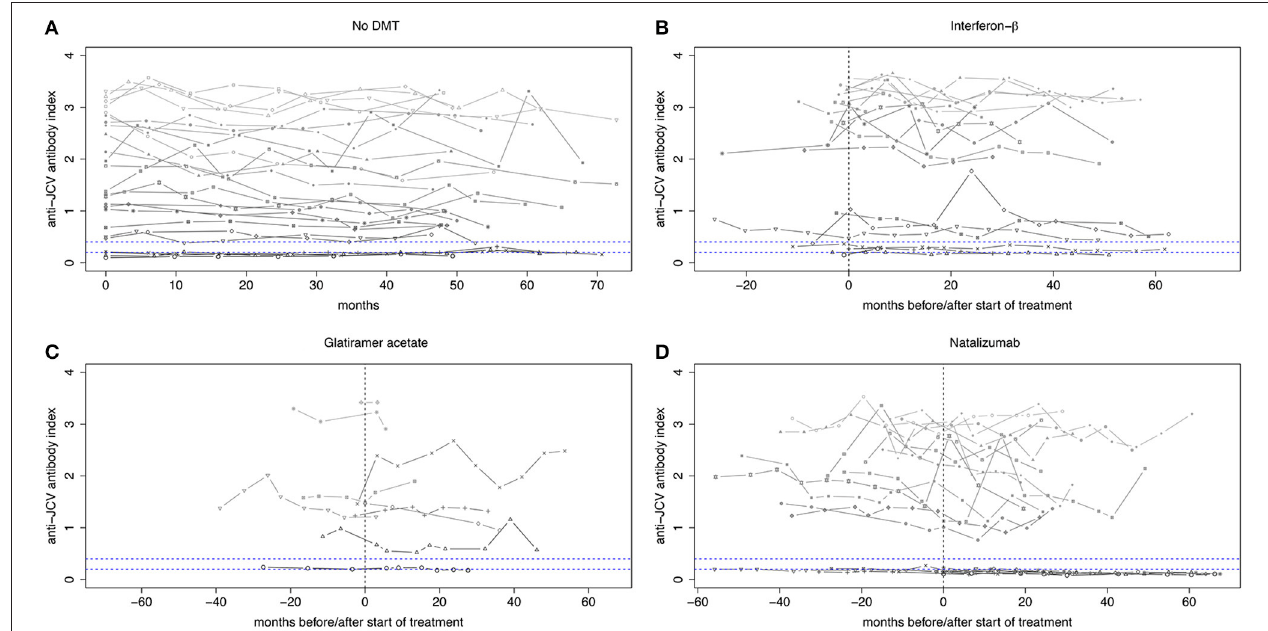
FIGURE 2 | Longitudinal evolution of anti-JCV antibody index in patients with stable anti-JCV antibody status. (A) Serial anti-JCV antibody indices in patients without any disease-modifying treatment. (B) Serial anti-JCV antibody indices in patients before and after start of IFN- β therapy. Before, all patients were treatment-naïve. Afterwards, index values are shown as long as IFN- β was administered. (C) Serial anti-JCV antibody indices in patients before and after start of GLAT therapy. After treatment begin, index values are shown as long as GLAT was administered. (D) Serial anti-JCV antibody indices in patients before and after start of NTZ therapy. All but one patient received prior treatment. Afterwards, index values are shown as long as NTZ was applied. For building this graph, only patients with stable anti-JCV antibody status (i.e., without seroconversion/-reversion) during the observation period were included. Using a mixed model, there was no statistically significant change of anti-JCV antibody index before and after initiation of the respective treatment. Vertical dashed line indicates start of treatment. Upper horizontal dashed line indicates an anti-JCV antibody index of 0.4. Index values > 0.4 are denoted anti-JCV antibody positive. Lower horizontal dashed line indicates an anti-JCV antibody index of 0.2. Index values < 0.2 are denoted anti-JCV antibody negative. Samples with an index ≥ 0.20 but ≤ 0.40 (intermediate response) are classified as anti-JCV antibody positive or negative based on confirmation test (second step of the enzyme-linked immunosorbent assay), i.e., the displayed index values within this range